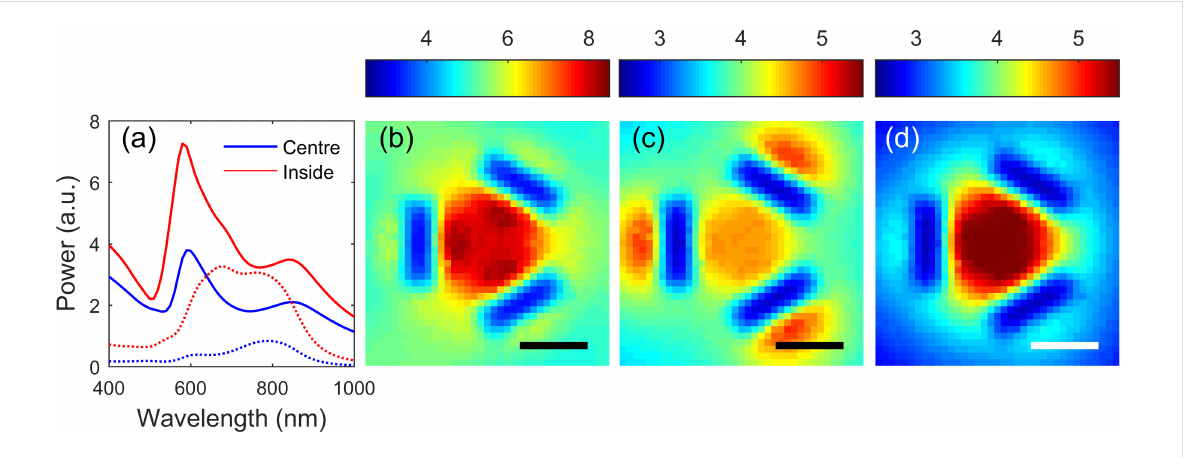
Figure 6: Simulated power radiated by a vertically oriented point dipole located 30 nm above a 100 nm thick gold film with three slots arranged in a triangular arrangement with length 150 nm and width 65 nm and separation of 100 nm. The spectra reflected from (solid curves) and transmitted through (dashed curves) the surface for dipoles located above the centre of the configuration and 5 nm outside the inner edge of one of the slots. The reflected power as a function of transverse dipole position is shown at wavelengths of (b) 600 nm, (c) 790 nm and (d) 860 nm. Scale bar is 100 nm.